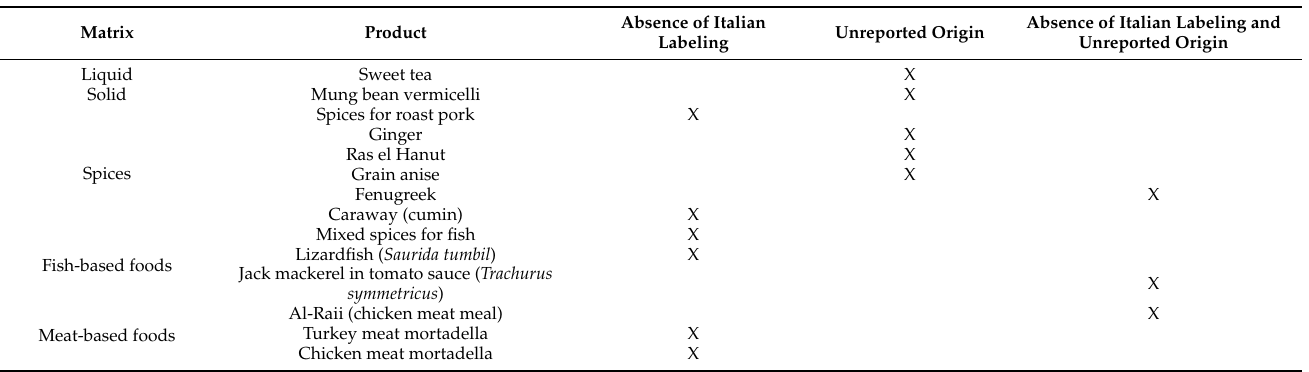
Table 4. Visual inspection of ethnic food labels.